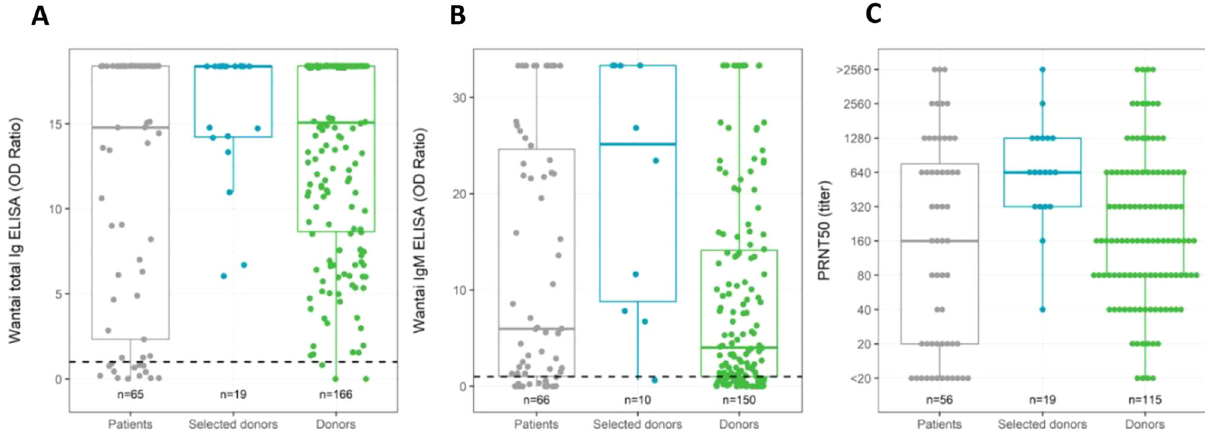
Fig. 4 Antibodies against receptor-binding domain and viral neutralization capacity in patients and donors. A SARS-CoV-2 total Ig against SARS-CoV-2 receptor-binding domain (RBD) measured by Wantai ELISA. B SARS-CoV-2 IgM against SARS-CoV-2 RBD measured by Wantai ELISA. C Viral neutralization capacity measured as PRNT50 titer. SARS-CoV-2 total Ig and IgM against SARS-CoV-2 RBD and viral neutralization capacity were evaluated in the serum of COVID-19 patients (gray) at enrollment (day 1) and serum of donors at day of plasma donation (all 115 donors tested: green; donors of whom plasma was selected for use in the study: blue). Box plots indicate median (middle line), 25th, 75th percentile (box), and 5th and 95th percentile (whiskers), as well as outliers (single points). Dashed line indicates positive cutoff at 1.0 optical density (OD) ratio for both total Ig and